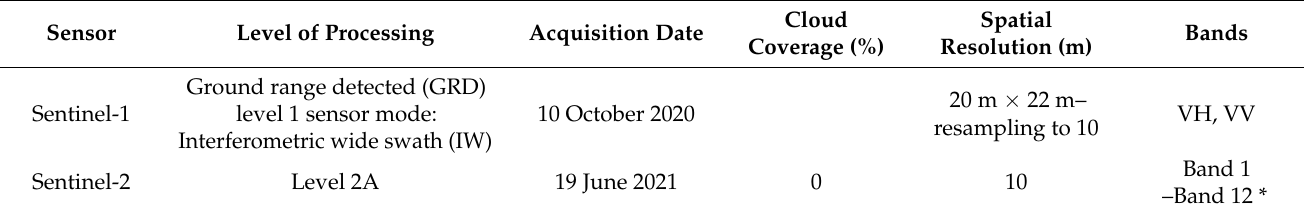
Table 1. S-1 and S-2 image properties for water extraction and lotus mapping.